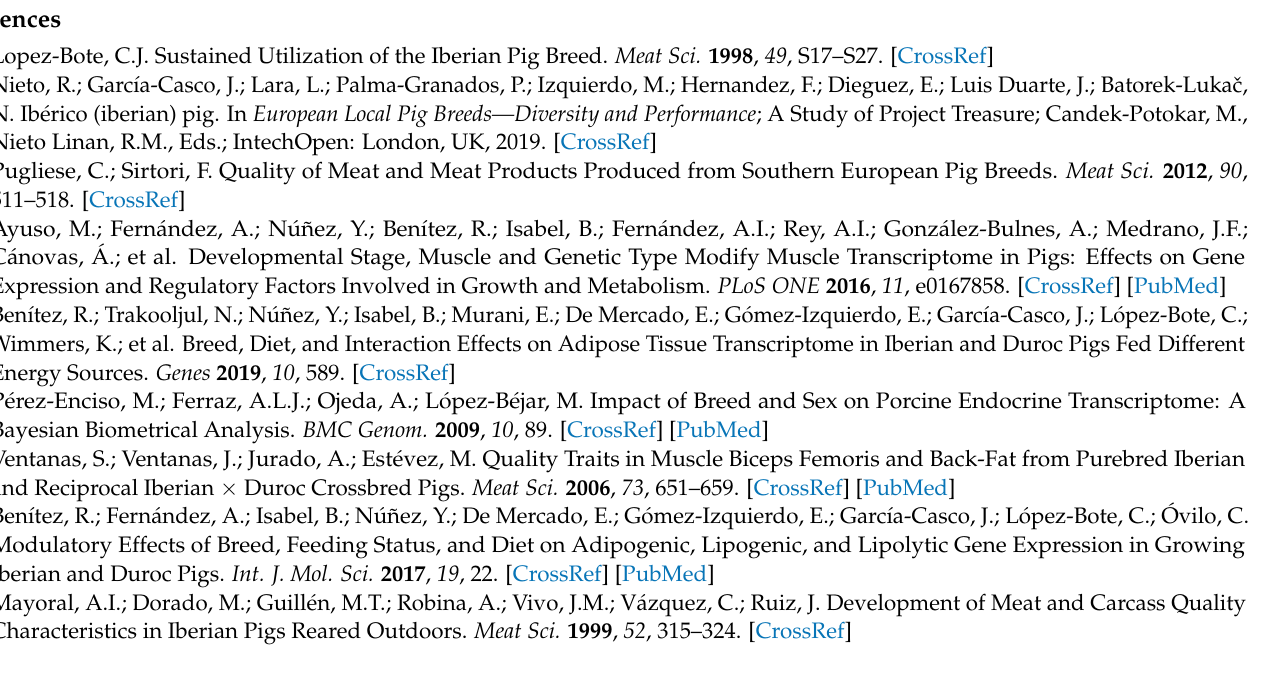
Table S3: fatty acid composition; Table S4: DEGs age effect; Table S5: biological functions age effect; Table S6: canonical pathways age effect; Table S7: upstream regulators age effect; Table S8: DEGs breed effect; Table S9: biological functions breed effect; Table S10: canonical pathways breed effect; Table S11: upstream regulators breed effect; Table S12: common genes between DEGs affected by age and breed effects; Table S13: DEGs diet effect; Table S14: DESeq2 results for the different interaction